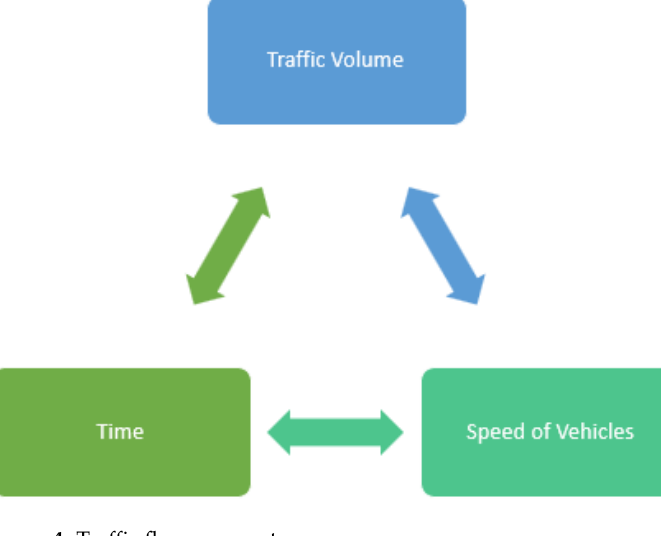
Figure 4. Traffic flow parameters.